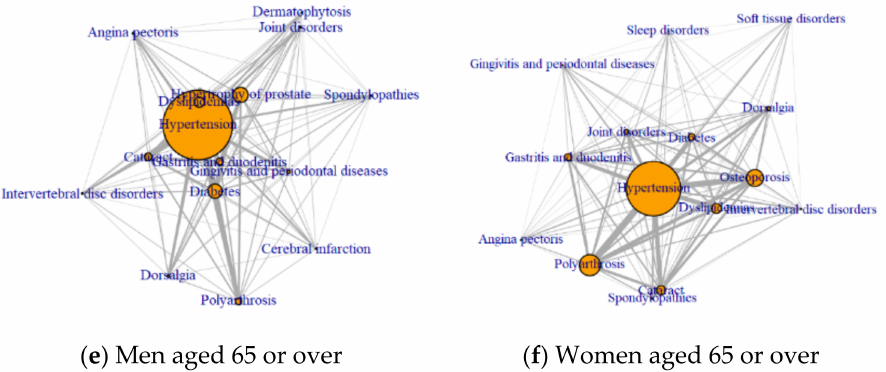
Figure 2. Network of frequent disease based on centrality by gender and age. ( a ) Men; ( b ) women; ( c ) men aged under 65; ( d ) women aged under 65; ( e ) men aged 65 or older; and ( f ) women aged 65 or